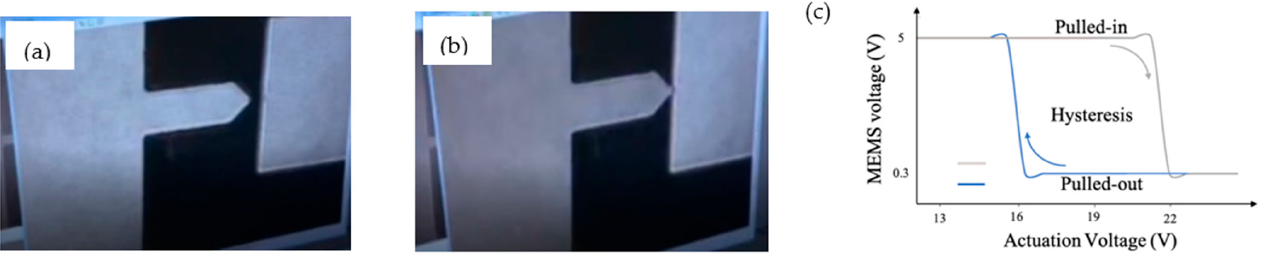
Figure 14. ( a ) SEM view of the contact tip after the long-term operation causing damage to the metal film. ( b ) SEM view of the damaged metal film on output electrode. 5. Conclusions The concept of performing sensing and computing using MEMS devices has great potential for advancing computing in many applications such as wearable devices, how- ever, poses new challenging problems that require new ways of thinking to solve. For example, this novel concept requires optimizing the MEMS design parameters to afford simultaneous sensing and computing. In this paper, however, we adopted a manual train- ing technique that solves intuitively the computing behavior, while ignoring the sensing limitation. While our simulation shows a great response, the real implementation and fab- rication of this MEMS CTRNN network revealed that its sensing mechanical parameters